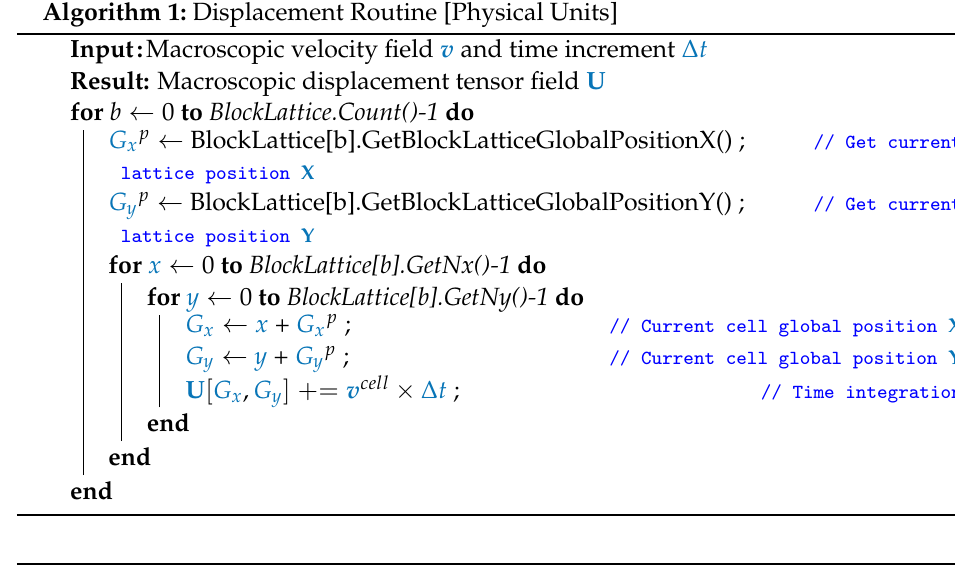
Algorithm 2: Strain and Stress Routine [Physical